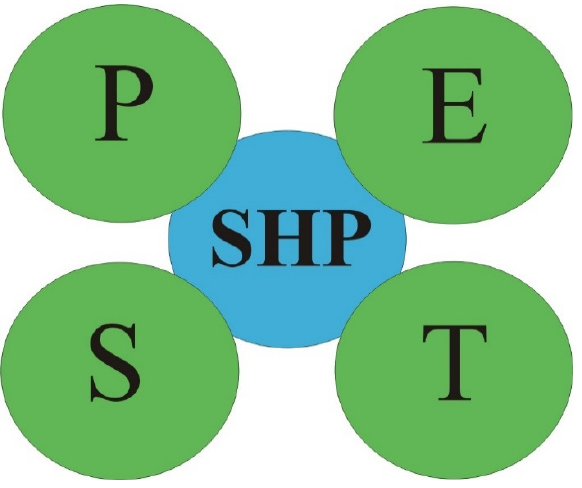
Figure 5. Macro-environmental factors SHP; P—political, E—economical, S—social, T—technological (PEST analysis) (own elaboration).